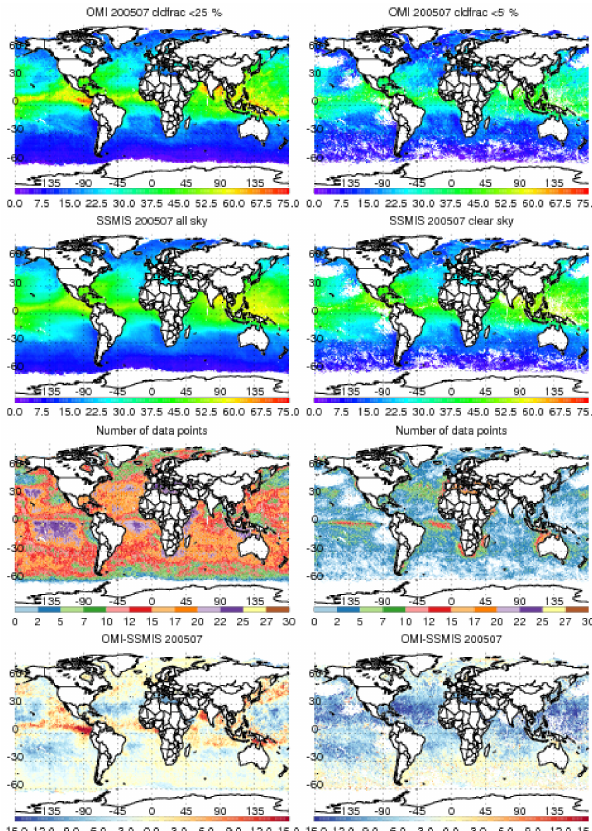
Figure 8. First row: monthly mean version 1.0 OMI TCWV (mm) for cloud fraction (left) < 25% and (right) < 5% for July 2005. Second row: monthly mean SSMIS TCWV (mm) for July 2005 for (left) all sky and (right) “clear” sky conditions. Third row: number of coincident data points per pixel within July 2005 for the corre- sponding column. Fourth row: first row − second row. White areas in the maps represent missing